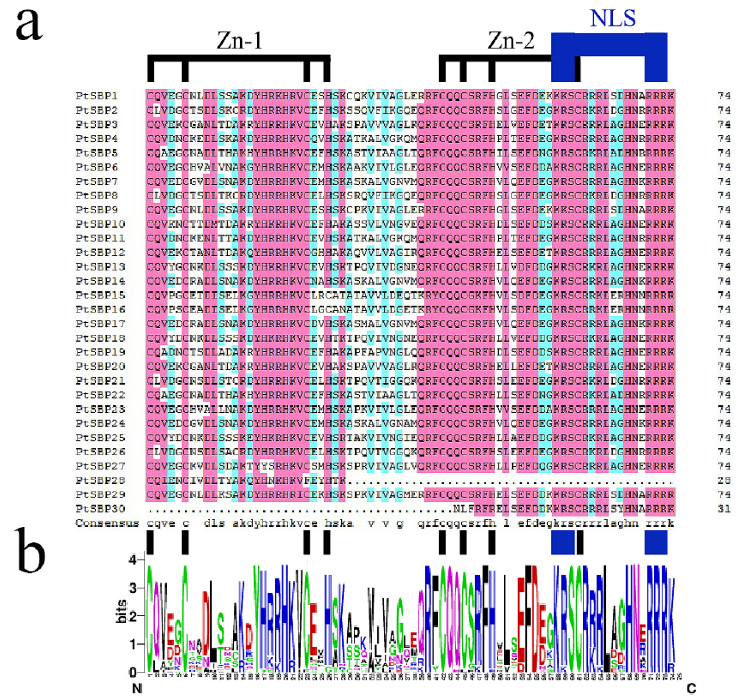
Figure 1. Alignment of SBP domains in poplar SBP gene. ( a ) Multiple alignment of PtSBP protein domain obtained by means of DNAMAN software (version 8.0), which pointed out two conserved zinc finger structures (Zn-1, Zn-2) and nuclear localization signal (NLS). ( b ) WebLogo is used to display the sequence markers of the poplar SBP domain. The total height of each column of letters indicates the degree of conservation of each position, and the height of each letter indicates the relative evaluation rate of the corresponding amino acid.